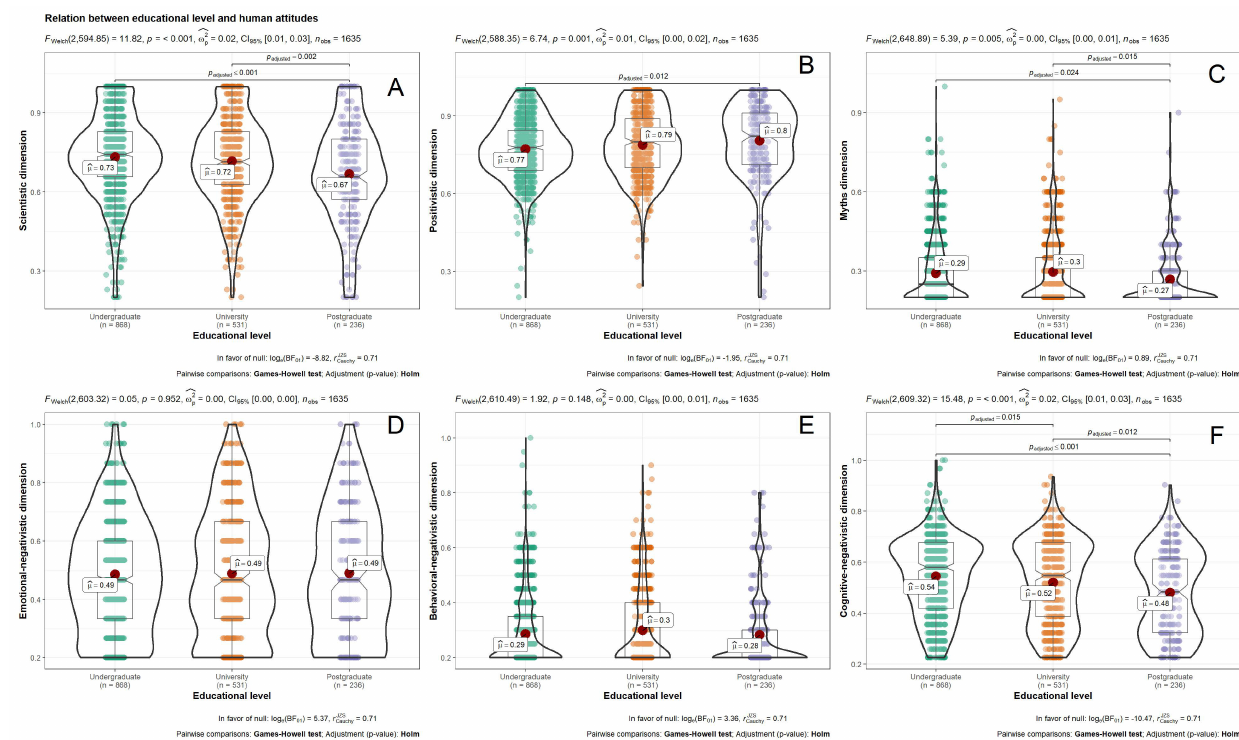
Figure 3. Differences of means in the factors and facets of the BAtSS, according to educational level: ( A ) = Scientific dimension; ( B ) = Positivistic dimension; ( C ) = Myths dimension; ( D ) = Emotional negativistic dimension; ( E ) = Behavioral negativistic dimension; ( F ) = Cognitive negativistic